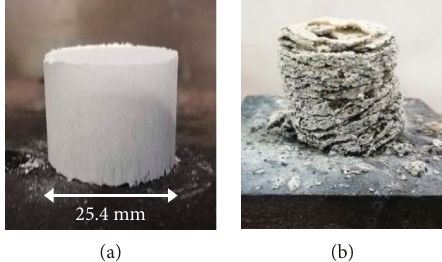
Figure 2: Digital photographs of a typical (a) green pellet of the reactants and (b) as-combusted